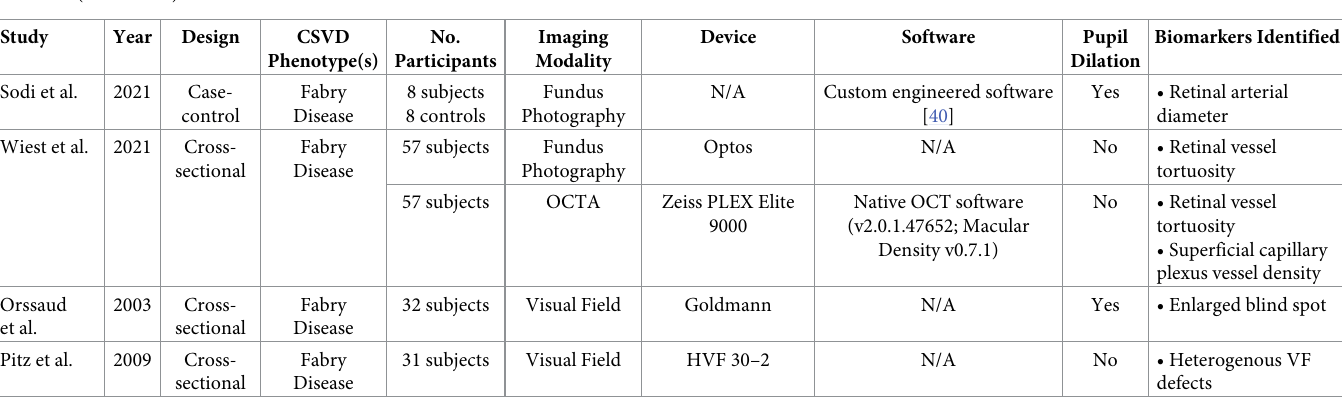
Abbreviations: CSVD = Cerebral Small Vessel Disease, ERG = Electroretinography, OCT = Optical Coherence Tomography, OCTA = Optical Coherence Tomography Angiography, WMH = White Matter